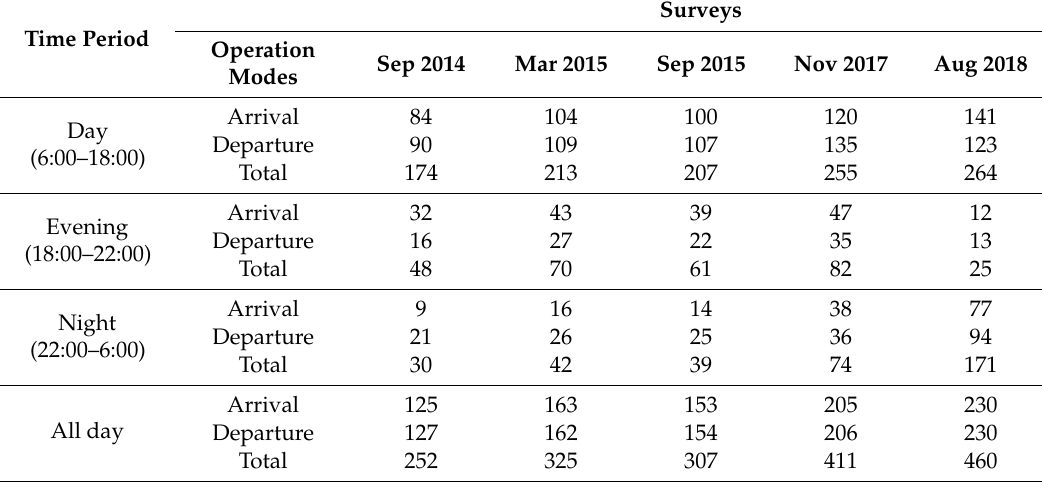
Table 3. Average number of aircraft noise